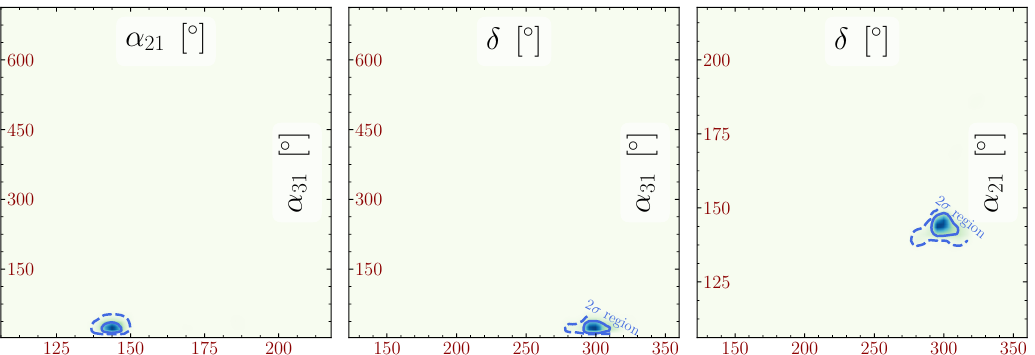
Figure 18 . The two-dimensional projections for intermediate scale leptogenesis with M 1 = 3 : 16 10 6 GeV and m 1 = 0 : 05 eV with CP violation provided only by the phases of the PMNS matrix. Solid lines correspond to 68% con(cid:12)dence level and dashed to 95% con(cid:12)dence level in agreement with the observed value (cid:17) B . This plot was created using SuperPlot CMB